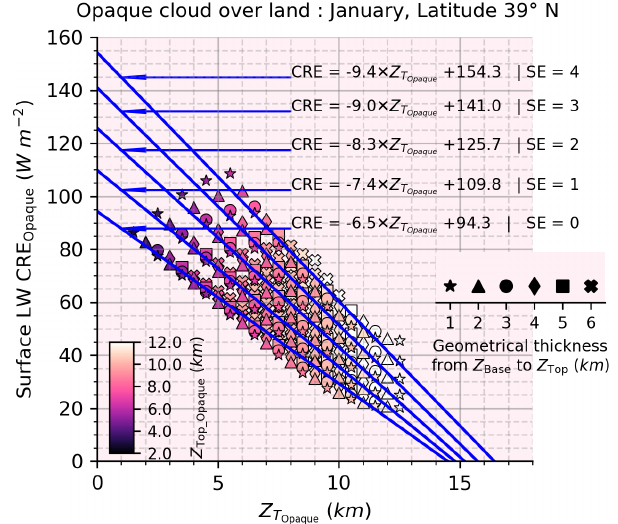
Figure 6. Sensitivity of the surface LW opaque CRE to the surface elevation (SE): same as Fig. 3a but over land and for different values of SE: SE = 0 (sea level), SE = 1km, SE = 2km, SE = 3km, and SE = 4km for January at a latitude of 39 ◦